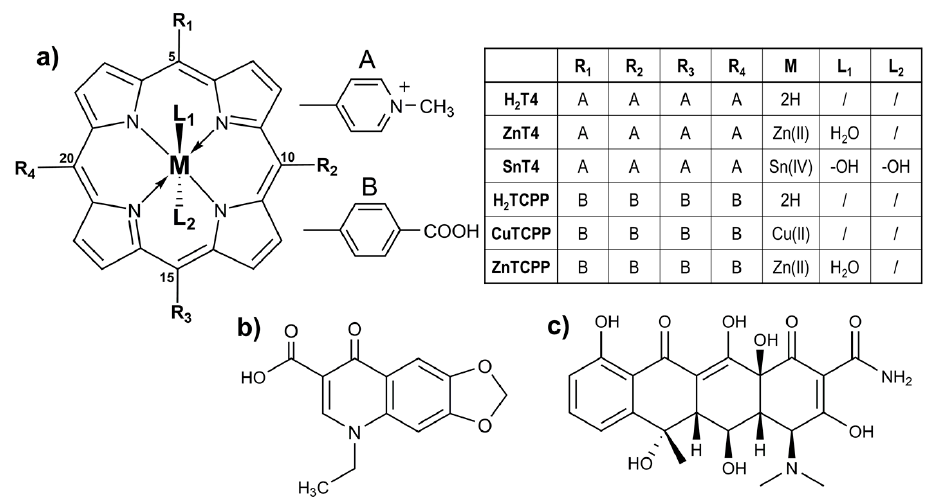
Figure 1. Molecular structures of ( a ) porphyrins used, ( b ) oxolinic acid, and ( c ) oxytetracycline.